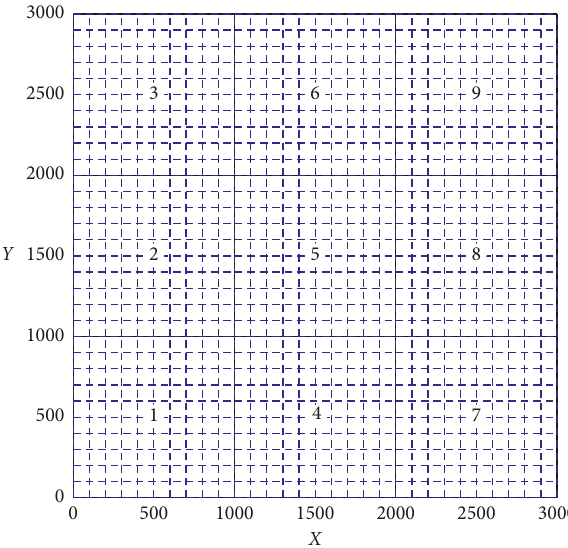
Figure 3: Illustrative model containing